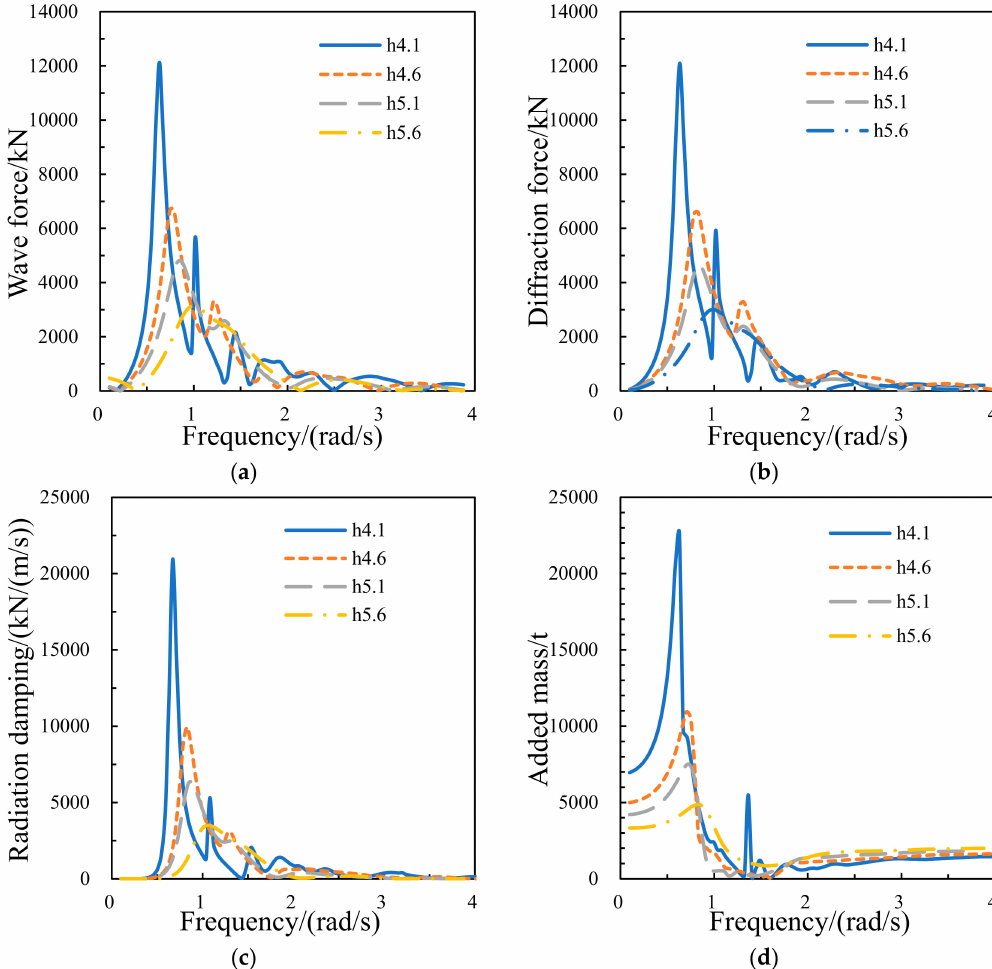
Figure 19. Four hydrodynamic parameter curves. ( a ) Wave force, ( b ) di ff raction force, ( c ) radiation damping, ( d ) added mass.